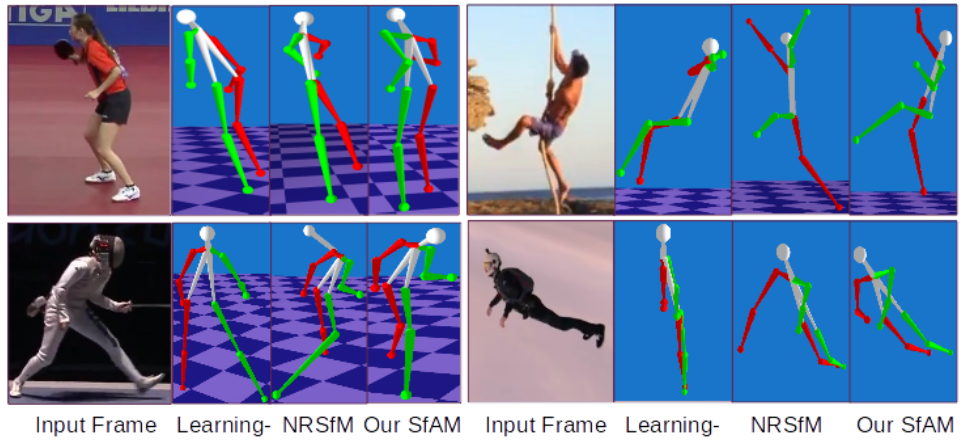
Figure 6. Comparison of our SfAM, NRSfM [11], and the learning-based method of Martinez et al. [9] on challenging real-world videos.